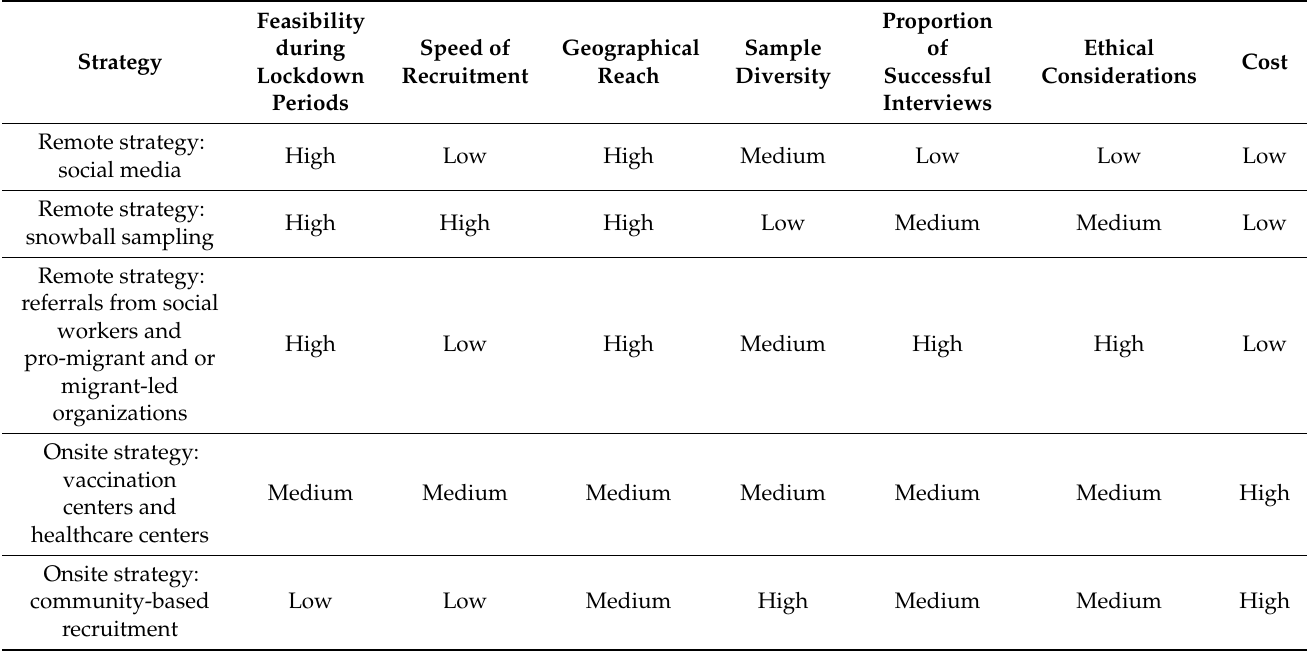
Table 3. Summary of the qualitative evaluation of each